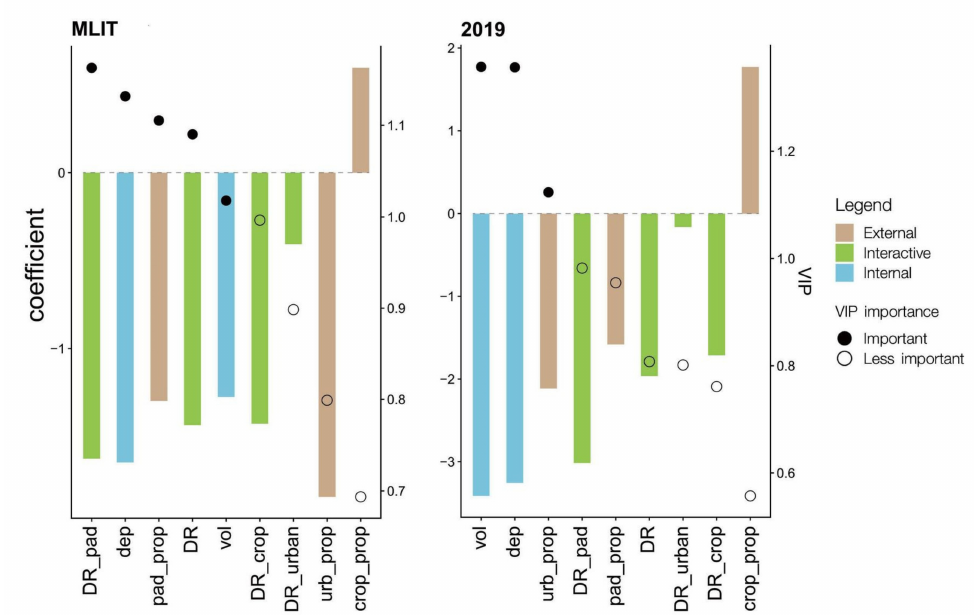
Figure 3. Partial least squares (PLS) regression output for the organic matter content (%) in MLIT data and 2019 data. Variables are listed with regression coefficients in descending variable importance to the projection (VIP) index order. VIP > 1 is considered important (filled circles) and VIP < 1 is less important (open circles). Abbreviations: dep for depth; vol for volume; DR for drainage index; DR_pad, DR_crop and DR_urban for drainage index based on the total area of paddy fields, crop fields, urban areas, respectively; pad_prop, crop_prop, and urb_prop for the proportion of paddy fields, crop fields, and urban areas,